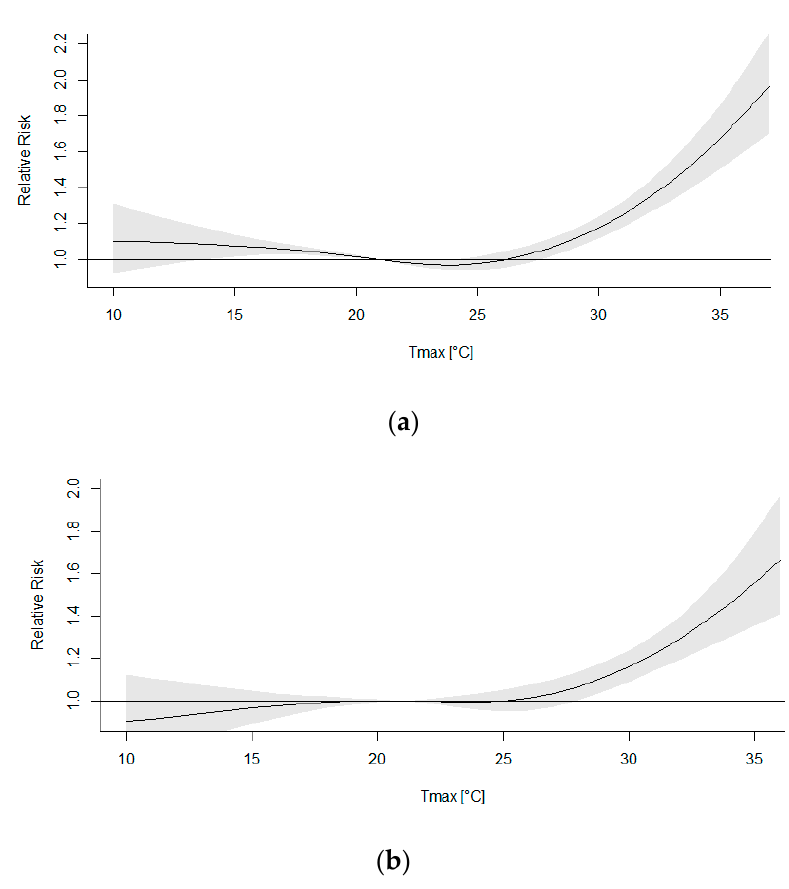
Figure 10. Relation between daily maximum temperature and relative mortality risk (age 65 and older) in warm months (June–September) during 2001–2016: ( a ) Pozna´n; ( b ) towns with population of below 10 thousand in